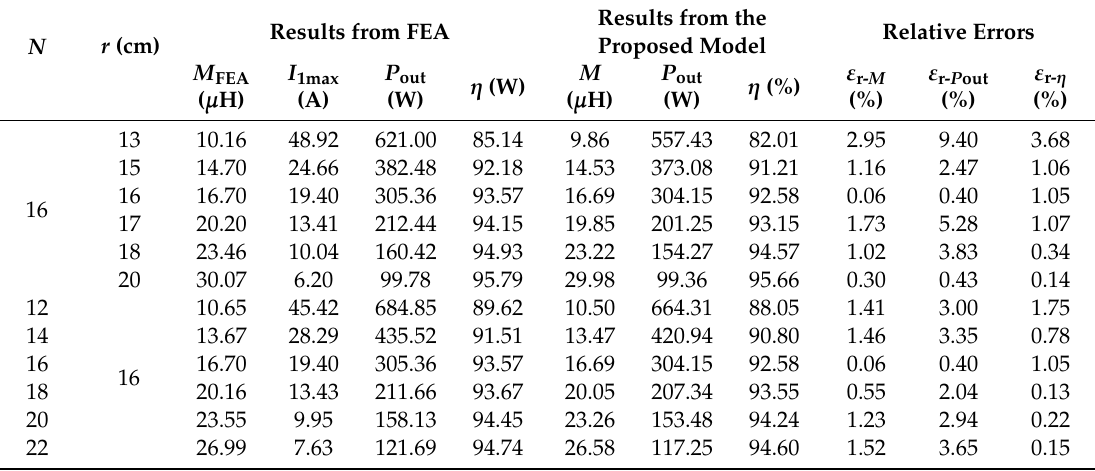
Table 2. Results based on finite element analysis (FEA) and the proposed